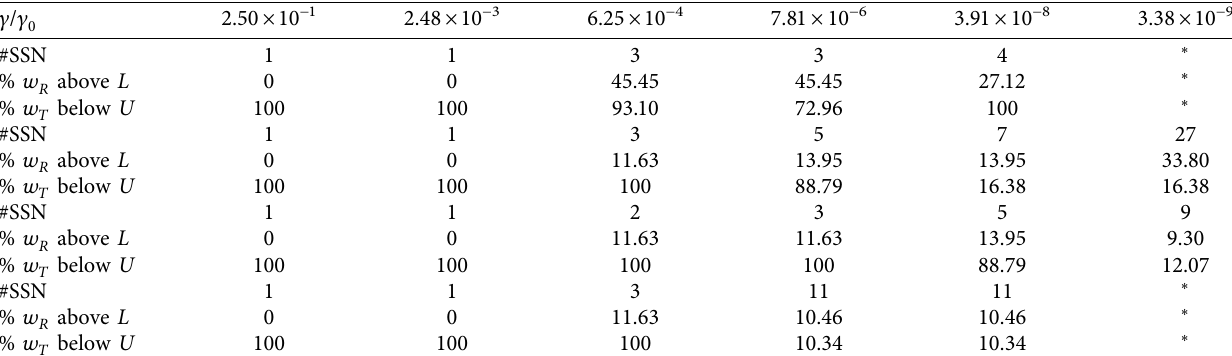
Table 2: Results for dose-constrained equation (3): number of SSN steps, volume fraction for risk, and target regions for diferent values of c . c / c 0